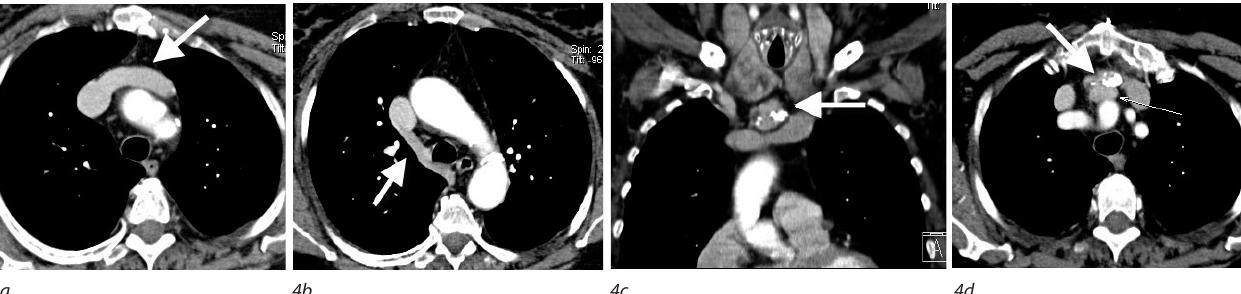
Fig. 4. Biphasic contrast injection single post-contrast injection series. The white arrow in 4a and 4b shows contrast-enhanced left brachiocephalic and azygos veins. The white arrow in Figs 4c and 4d show an enhancing ectopic thyroid nodule, with calcification, abutting on the enhanced left brachiocephalic